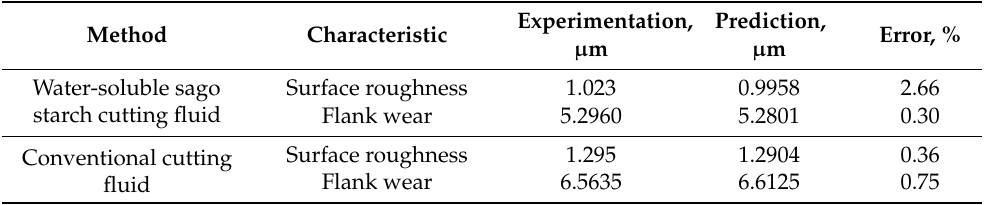
Table 12. Experimental and predicted values of surface roughness, flank wear at the optimum